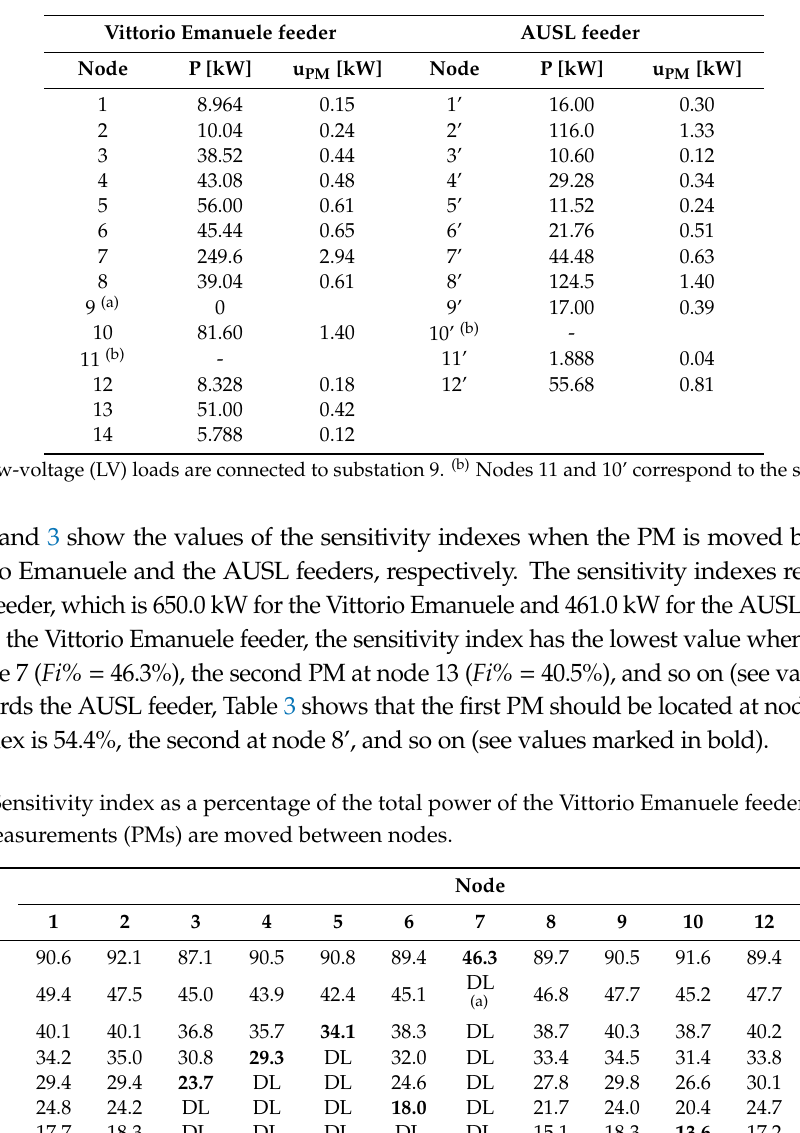
Table 1. Summer reference load condition.